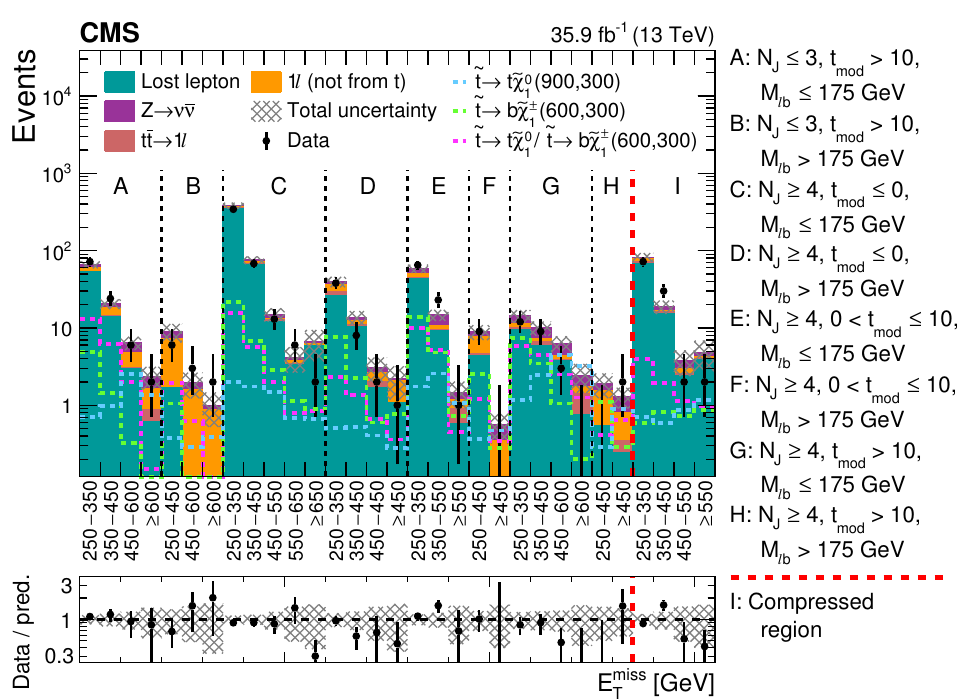
Figure 4 . Observed data yields compared with the SM background estimations for the 31 signal regions of tables 2 and 3. The total uncertainty in the background estimate, determined as the sum in quadrature of statistical and systematic uncertainties, is shown as a shaded band. The expectations for three signal hypotheses are overlaid. The corresponding numbers in parentheses in the legend refer to the masses in GeV of the top squark and the neutralino.